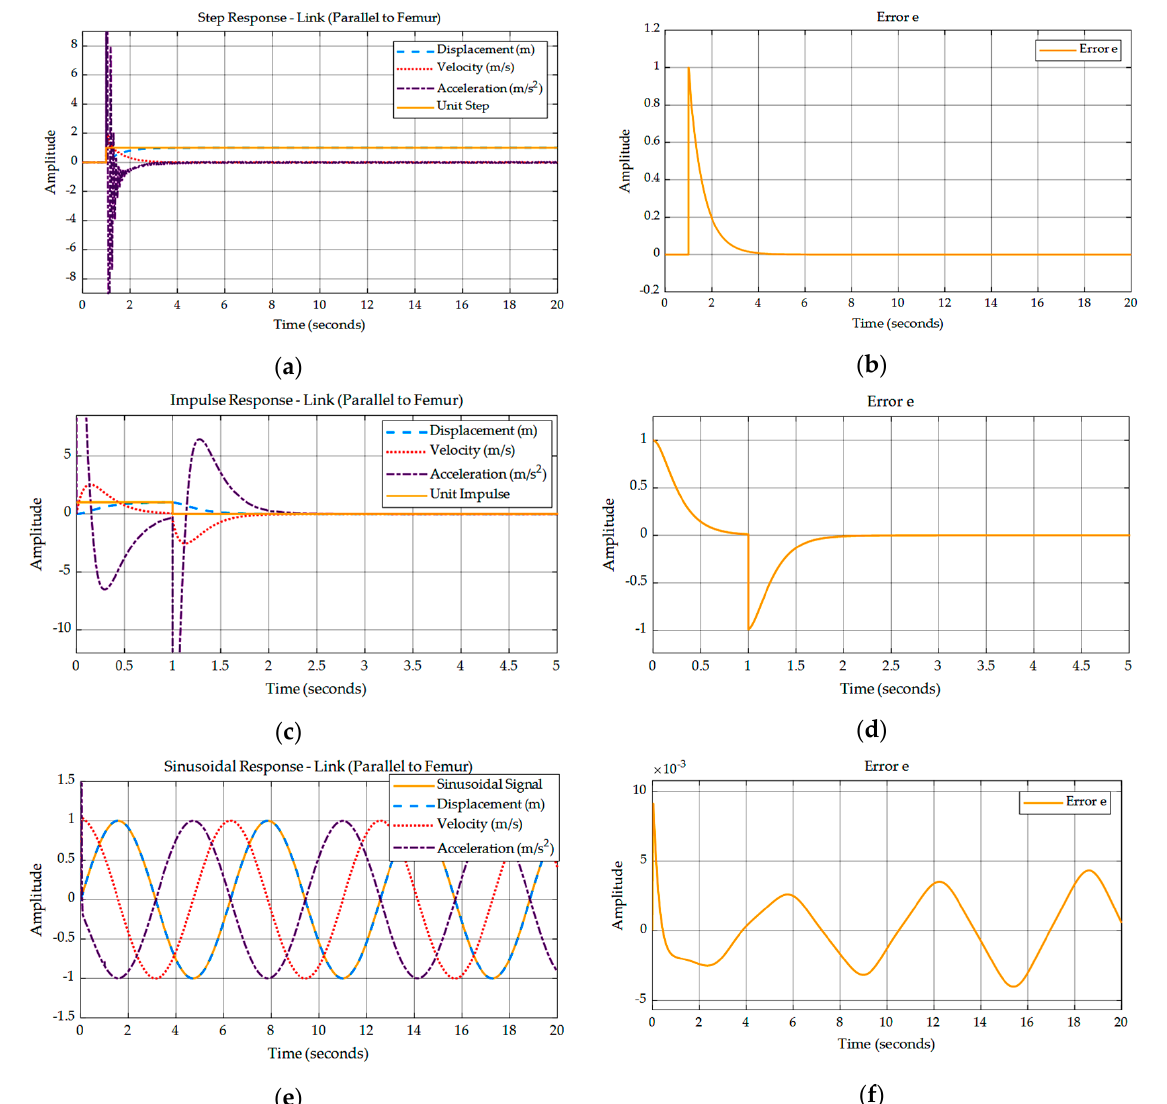
Figure 8. Model-free robust control design-closed loop responses of link (parallel to femur) and tracking error: ( a ) step response-displacement, velocity, and acceleration; ( b ) tracking error displacement step response; ( c ) impulse response-displacement, velocity, and acceleration; ( d ) tracking error displacement impulse response; ( e ) sinusoidal response-displacement, velocity, and acceleration; ( f ) tracking error displacement sinusoidal response.